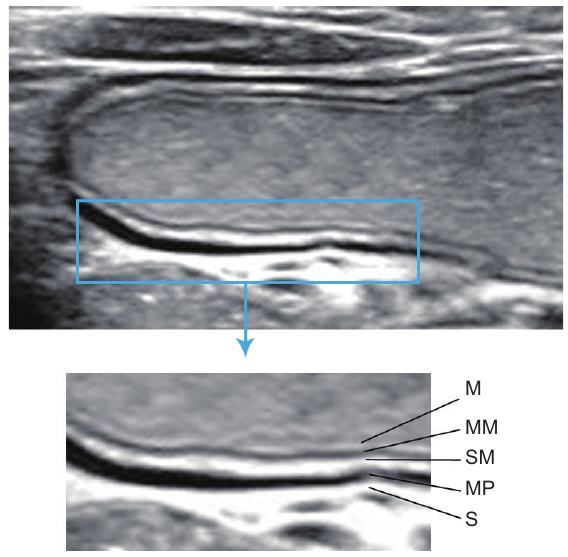
Figure 1 Ultrasound image of normal gastric wall. M, the first layer of hyperecho, equivalent to the echo of the gastric cavity interface and the superficial layer of mucosa; MM, the second layer is hypoechoic, equivalent to the mucosal muscular layer; SM, the third layer of hyperecho, equivalent to the submucosa; MP, the fourth layer is hypoechoic, equivalent to muscularis propria; S, the fifth layer is hyperechoic, equivalent to the serosal layer and extrasosal adipose tissue